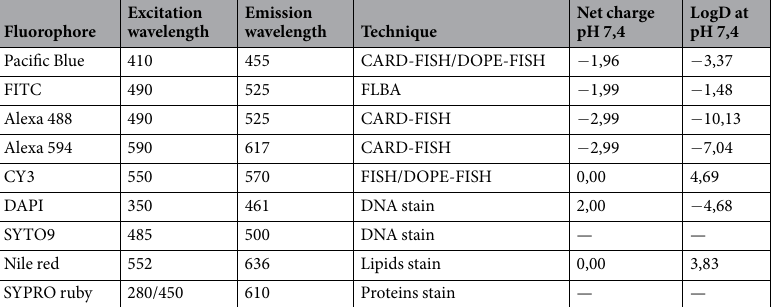
Table 1. Summary of dyes and fluorophores used in this study. Net charge and LogD were calculated using the molecular structure of the fluorophore with hydrolyzed reactive group. The molecular structure of Syto9 and Sypro ruby is not